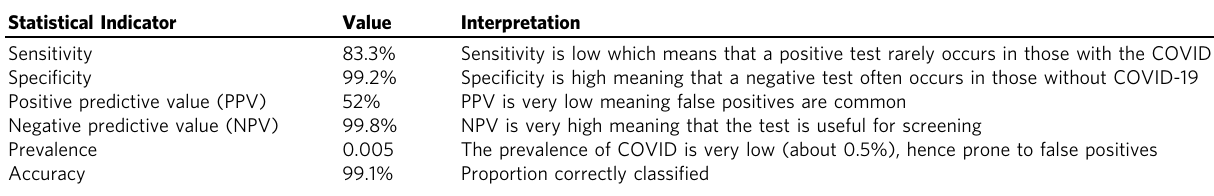
Table 2 Calculations of Statistical Indicators and their Interpretation.